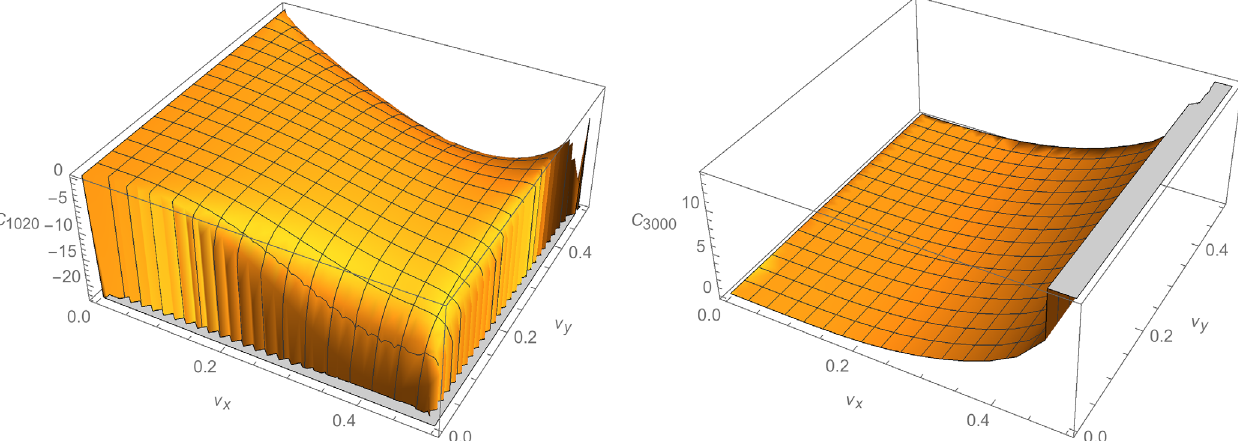
FIG. 3. The coefficients of resonance driving terms: ν